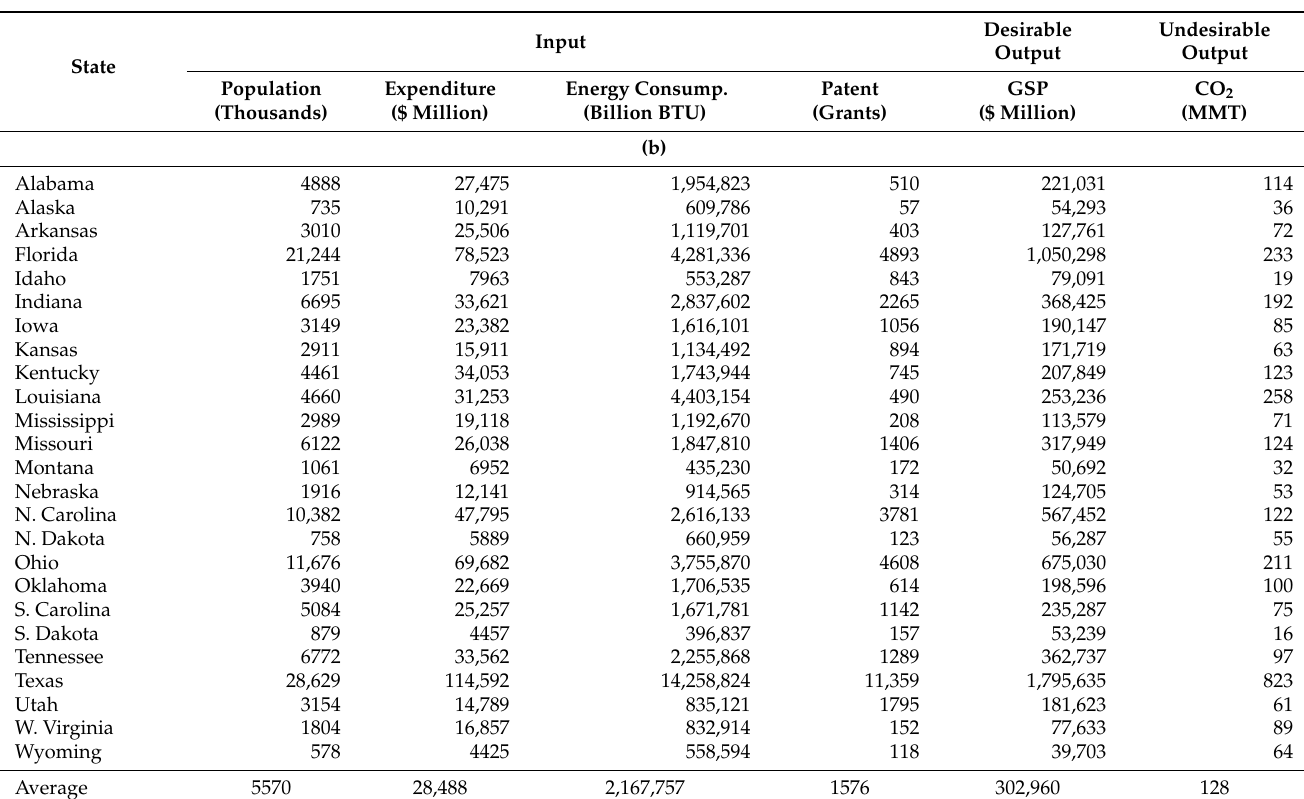
Table 5 shows the data statistics of two outputs: GSP and CO 2 . States’ mean values over 10 years are presented along with standard deviation values in the parenthesis. The descriptive statistics of blue states are presented first and that of red states later.